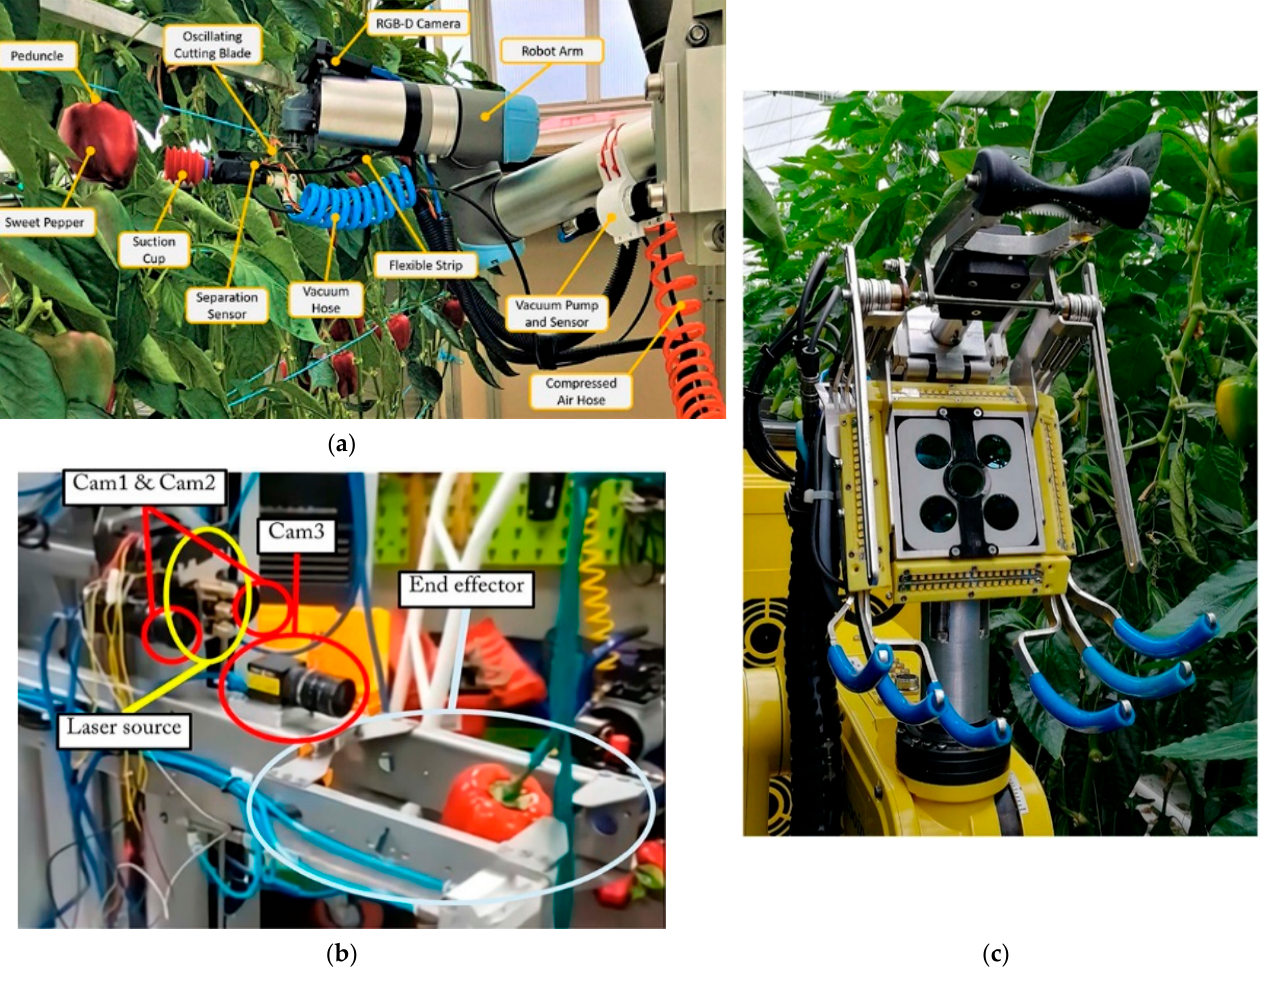
Figure 7. Indicative sweet pepper harvesting end effectors proposed by ( a ) Lehnert et al. (Reprinted/adapted with permission from Ref.[67], 2020, Lehnert, C.), ( b ) Lee et al. (Reprinted/adapted with permission from Ref. [68]. 2019, Lee, B.) and ( c ) Arad et al. (Reprinted/adapted with permission from Ref. [69]. 2020, Arad, B.).